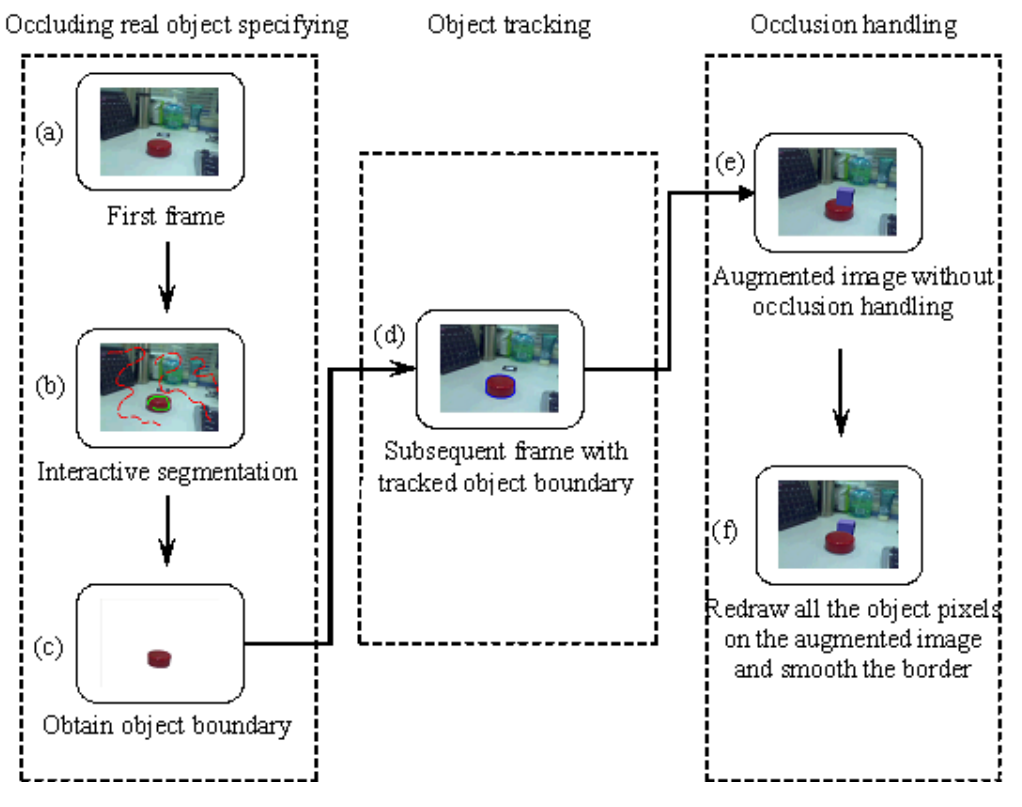
Figure 2. Work Flow of the Proposed